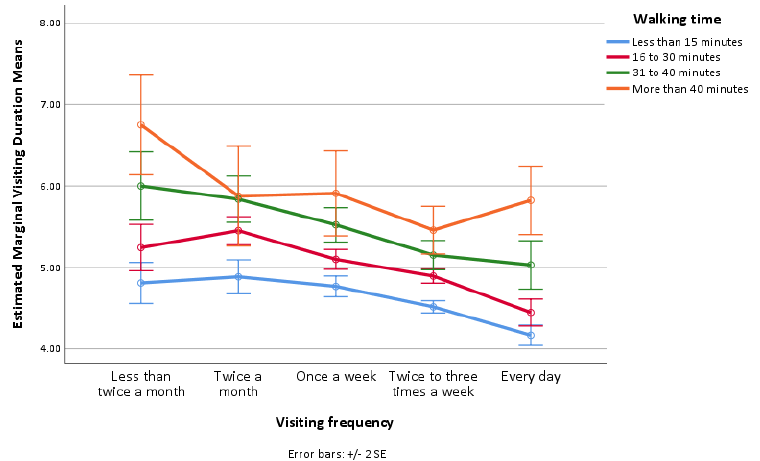
Figure 6. Estimated line charts of means for visiting time by the effect of walking time and visiting frequency.